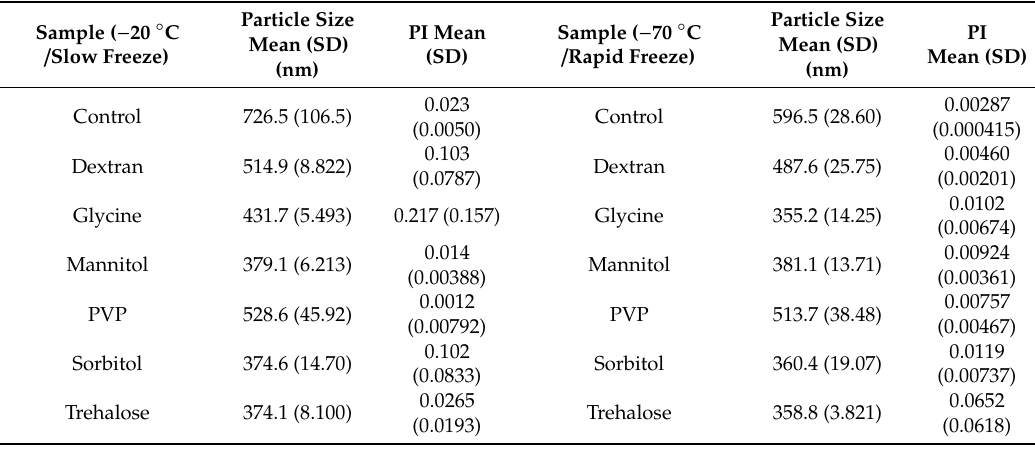
Table 3. Freeze–thaw study: E ff ect of cryoprotectant on the particle size and distribution of SLNs immediately after thawing; data presented as mean (standard deviation), N =